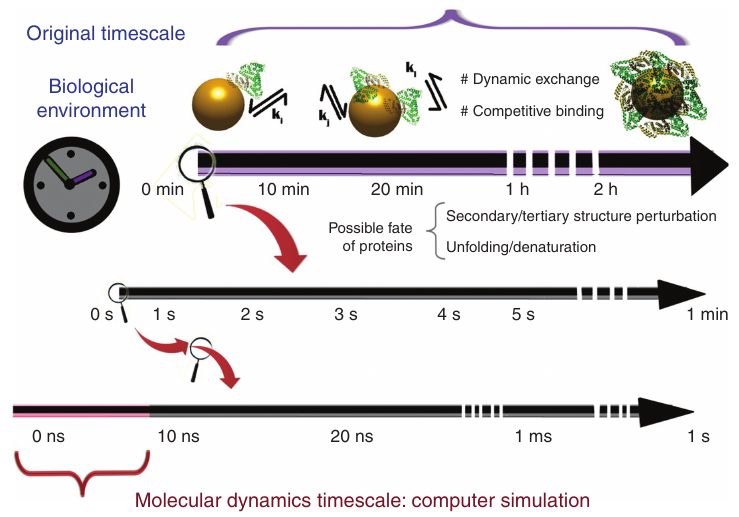
Figure 4 An inconsistency between the original timescale and the simulated timescale. In biological environment, it takes up to several hours to complete the process of protein adsorption. On the other hand, computer simulations like molecular dynamics can only simulate protein adsorptions in the scale of nanoseconds. In practice, binding of the proteins occurs in a competitive manner through dynamic exchange of different biomolecules or proteins. The structure deformations or unfoldings of proteins are few common possibilities in the course of time, eventually affecting the final adsorption process. It is a serious challenge to consider all these parameters in a computer